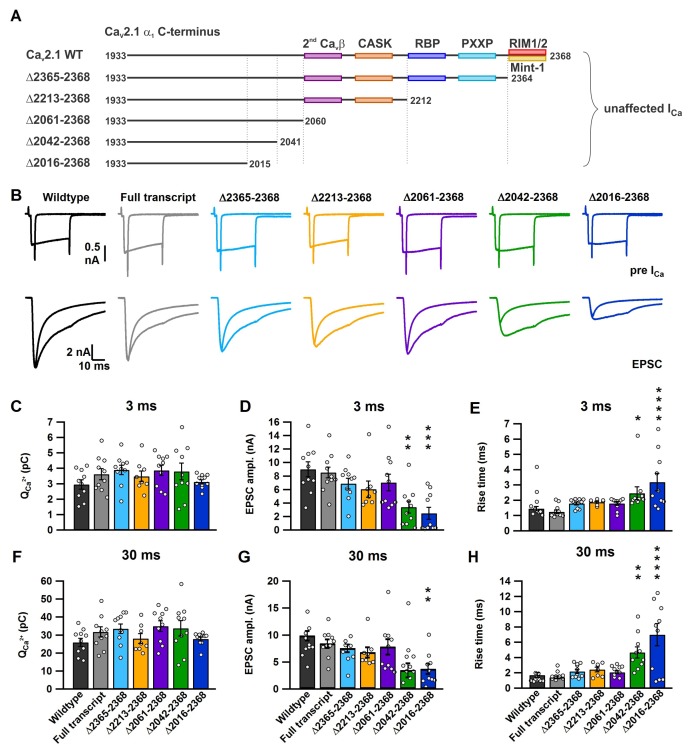
A novel role for a C-terminal region between amino acids 2042 and 2061 that regulates fast release independent of CaV2.1 abundance.(A) Cartoon depicting truncated regions in our CaV2.1 α1 deletion mutants including the binding sites for CaVβ4, CASK, RBP, PXXP, RIM1/2 and Mint-1 along with the effects of C-terminal truncations on ICa. (B) Averaged traces of RRP and total releasable pool measurements from mice expressing Cre + full transcript CaV2.1 rescue (grey), Δ2365–2368 (cyan), Δ2213–2368 (yellow), Δ2061–2368 (purple), Δ2042–2368 (green) or Δ2016–2368 (blue). ICa (top) and EPSCs (bottom) triggered by 3 ms and 30 ms pulses, plotted on top of each other (n = 10 for each group, except for Δ2212–2368: n = 8). (C–H) Quantification of ICa charge (3 ms: C; and 30 ms: F), max. EPSC amplitudes (3 ms: D; 30 ms: G) and the 10–90% rise of the EPSCs (3 ms: E; 30 ms: H). All data are depicted as mean ± SEM. Detailed values can be derived from Table 2.